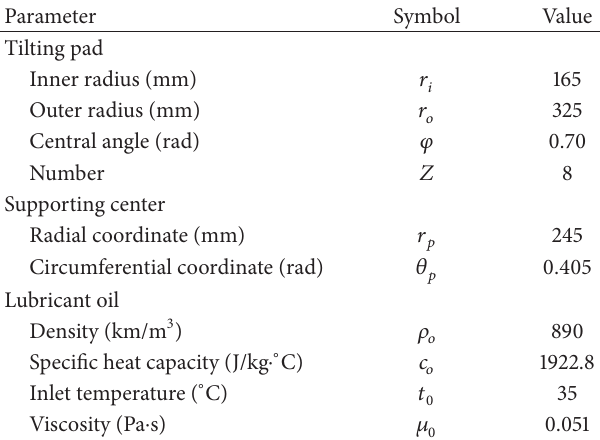
Table 1: Parameters of thrust bearing.